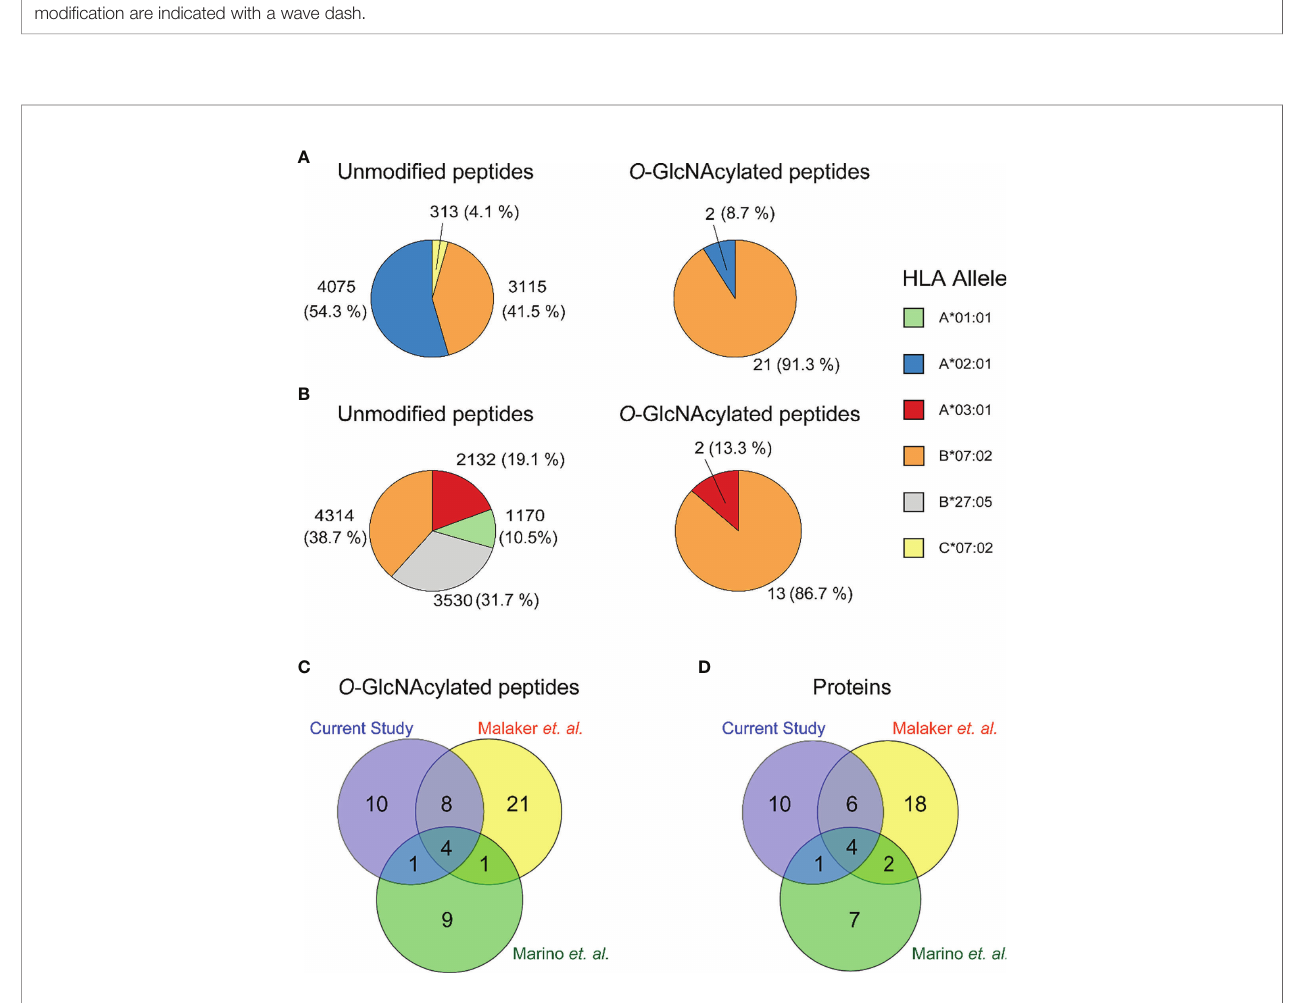
FIGURE 1 | Illustrative EThcD mass spectrum of the peptide TPASgSRAQTL, originating from Spectrin, in its O -GlcNAcylated form, modi fi ed at P5. Highlighted in green are the oxonium ions. Fragment ions that elucidate the amino acid sequence and the glycosylation site are labelled as b, c, y and z. The fragment ions without modi fi cation are indicated with a wave